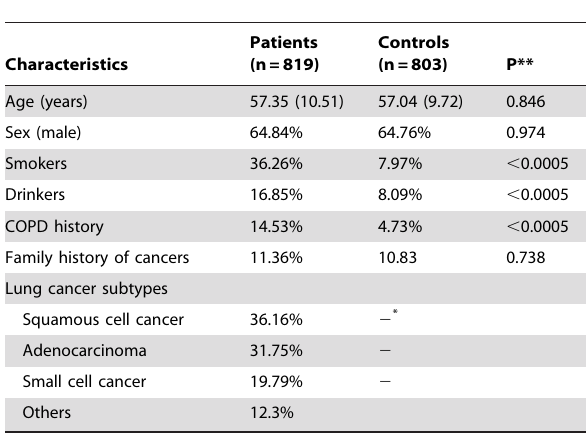
Abbreviations: COPD, chronic obstructive pulmonary disease. Data are expressed as mean (standard deviation or SD) or percentage as indicated. *data not available. **P values were calculated by using unpaired t-test for age, and by x 2 test for other categorical